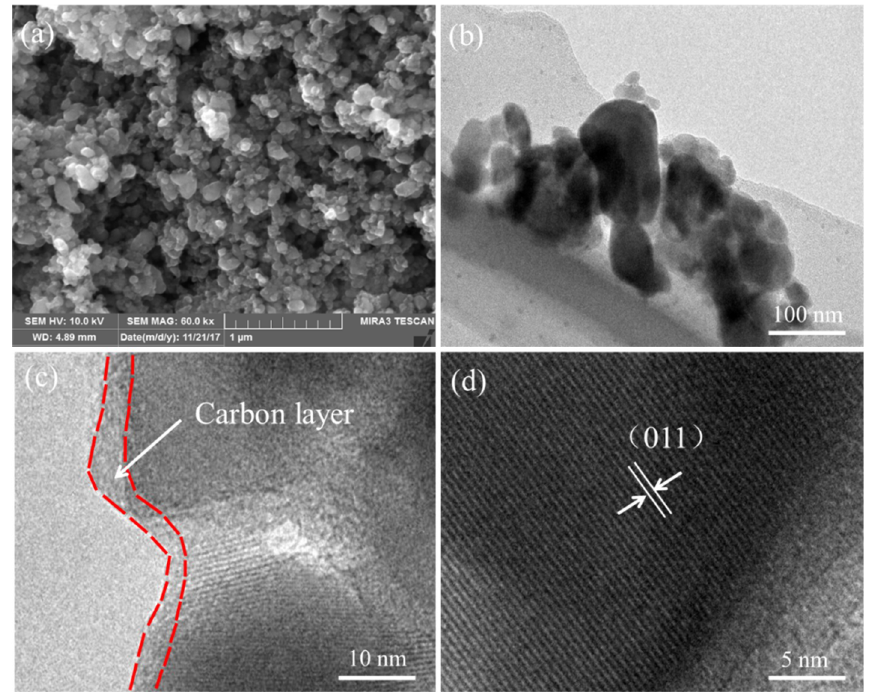
Figure 3. ( a ) SEM image of LiFePO 4 /C composite; and ( b – d ) TEM images of LiFePO 4 /C composite.